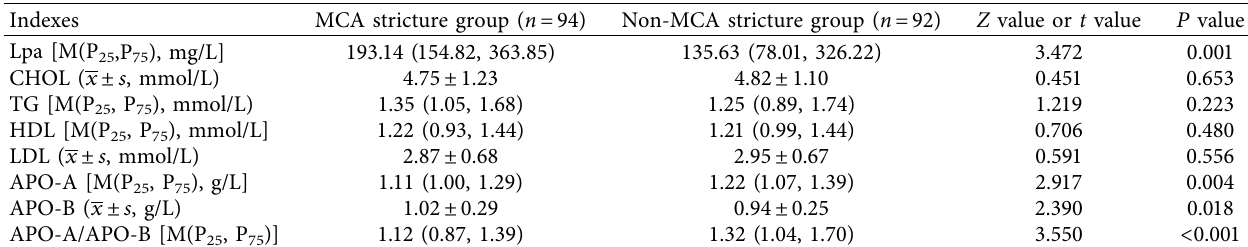
Table 2: Comparison of blood lipid metabolism indexes between the MCA stenosis group and the no MCA stenosis group.